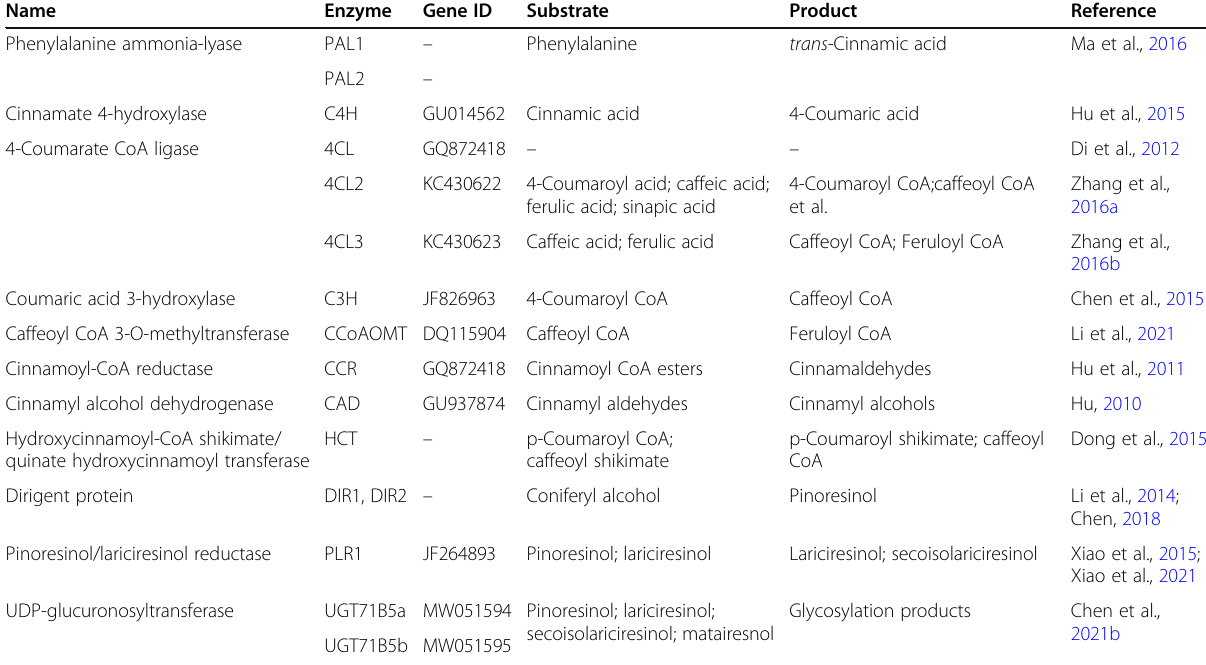
Table 1 Enzymes involved in lignan biosynthetic pathway of I.